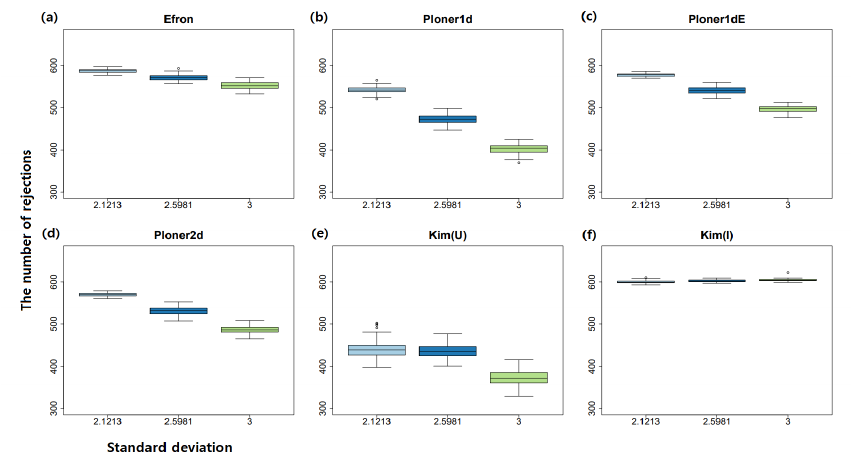
Figure 11. Scale change scenario and two-sided. The number of rejections by each method over 100 repetitions when cutoff = 0.1. Box plots for three mean values by each method: ( a ) Efron ( b ) Ploner1d ( c ) Ploner1dE ( d ) Ploner2d ( e ) Kim (Union) ( f ) Kim (Intersection).